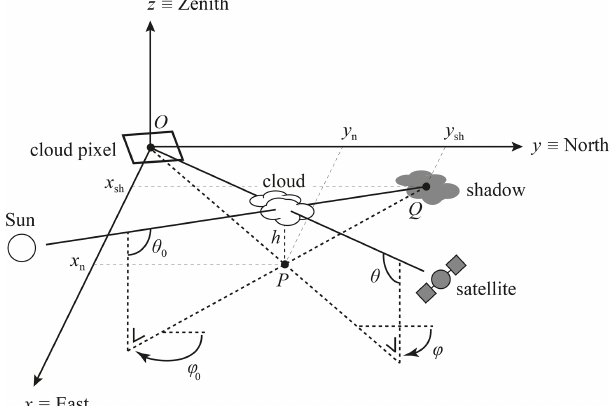
Figure 2. Sketch of the cloud shadow geometry in the local ref- erence frame at the Earth’s surface. The cloud as observed by the satellite is located at point O, resulting in a TROPOMI cloud pixel at O (indicated by the white quadrilateral), while the actual cloud is located at height h above point P. The shadow is located at point Q.